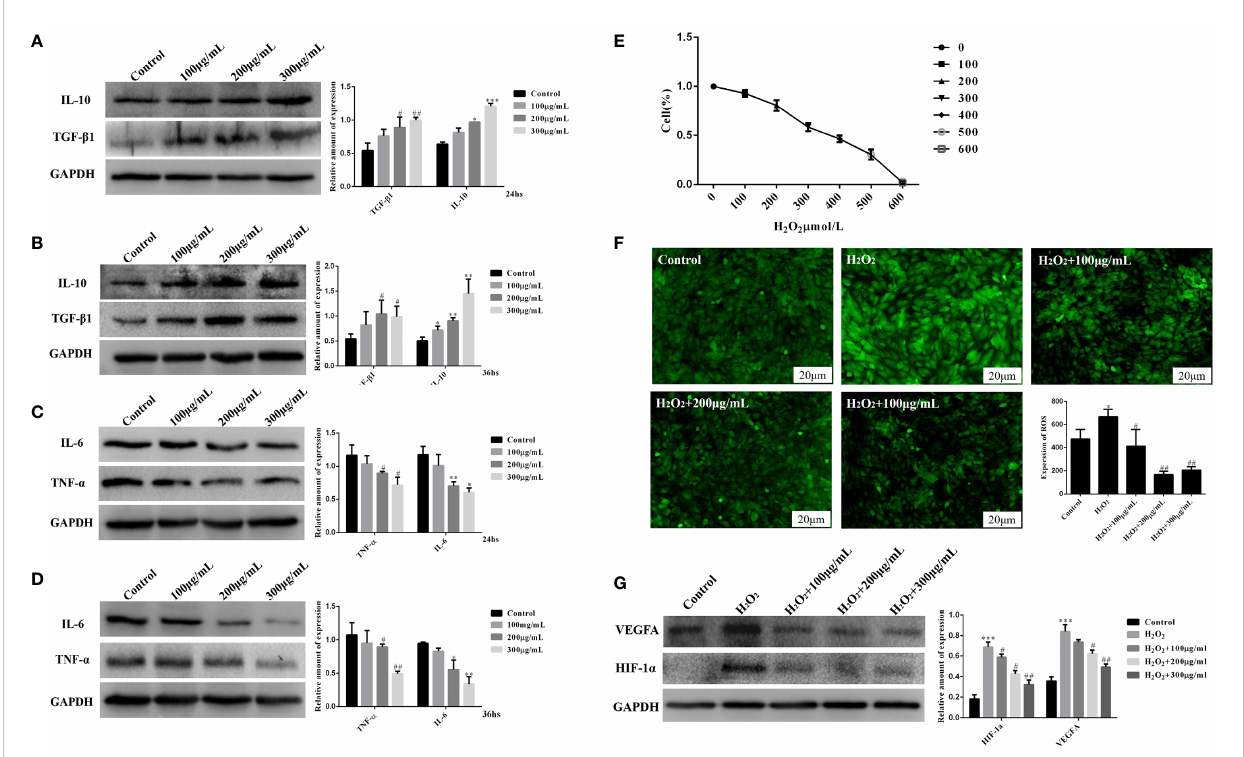
FIGURE 3 COS improves in fl ammatory and oxidative stress in KGN cells. COS promotes the expression of anti-in fl ammatory factors TGF- b 1 and IL-10 protein in KGN cells in a dose and time-effect relationship. (Protein expression of TGF- b 1 and IL-10 after COS culture for 24 hours (A) ; Protein expression of TGF- b 1 and IL-10 after COS culture for 36 hours (B) . COS inhibits the expression of pro-in fl ammatory factors TNF- a and IL-6 in KGN cells in a dose and time-dependent relationship. (Protein expression of TNF- a and IL-6 after COS culture for 24 hours (C) ; Protein expression of TNF- a and IL-6 after COS culture for 36 hours (D) . Determination of IC50 Value of Hydrogen Peroxide Damage to KGN Cells (E) . COS reduces H 2 O 2 -induced reactive oxygen generation in KGN cells (F) . COS inhibits the protein expression of HIF-1 a and VEGFA in KGN cells in a dose-dependent manner (G) .